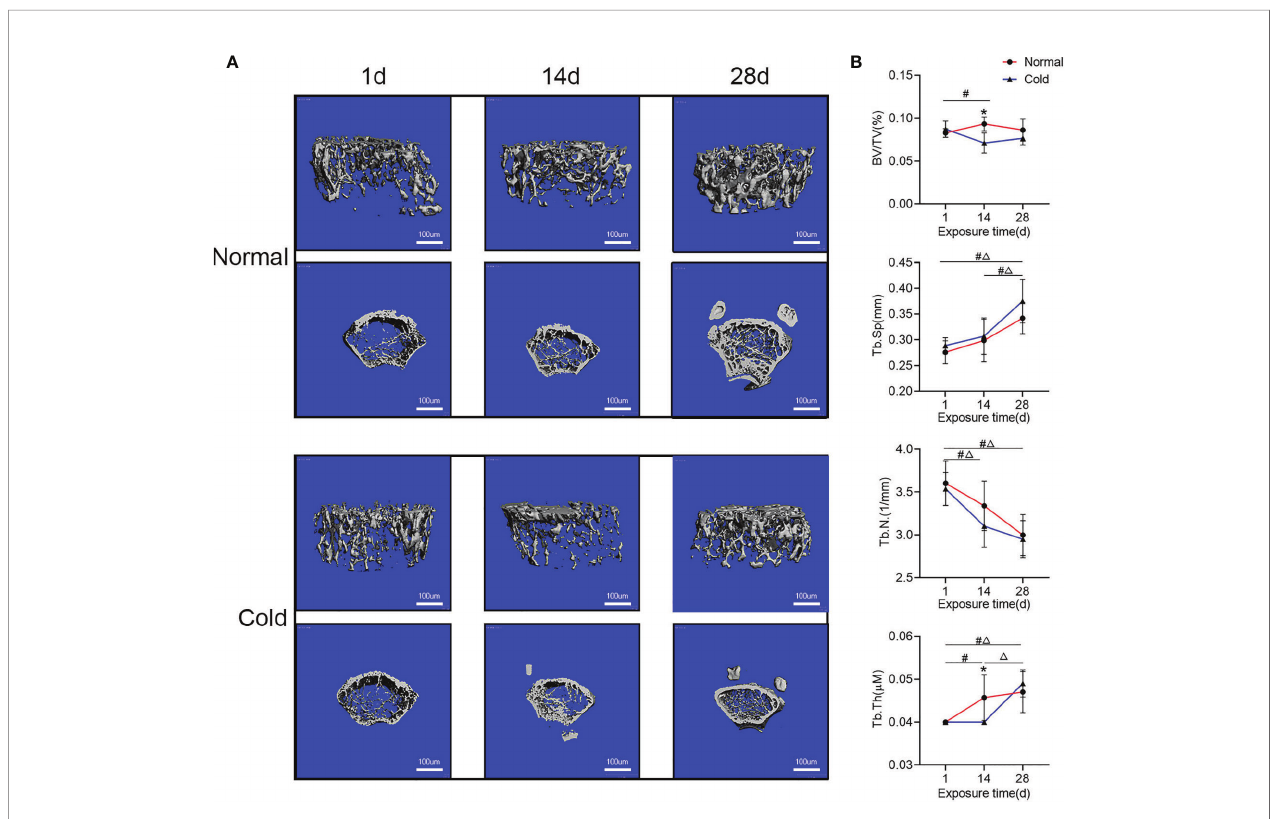
FIGURE 1 | Bone mass fl uctuates with increased time. (A) Representative images of micro-CT are shown. (B) Trabecular bone microarchitecture of tibias showing bone volume/ total volume (BV/TV), trabecular number (Tb.N), trabecular separation (Tb.Sp), and trabecular thickness (Tb.Th). Data are shown as the mean ± SD (n=5 per group). Signi fi cance (p- value) was calculated using two-way ANOVA, *p < 0.05, cold group vs . normal group; # p < 0.05, difference at different time points in the normal group; D p < 0.05, difference at different time points in the cold group; 1 day (1 d), 14 days (14 d), 28 days (28 d), Normal: mice at room temperature (23°C), Cold: mice at